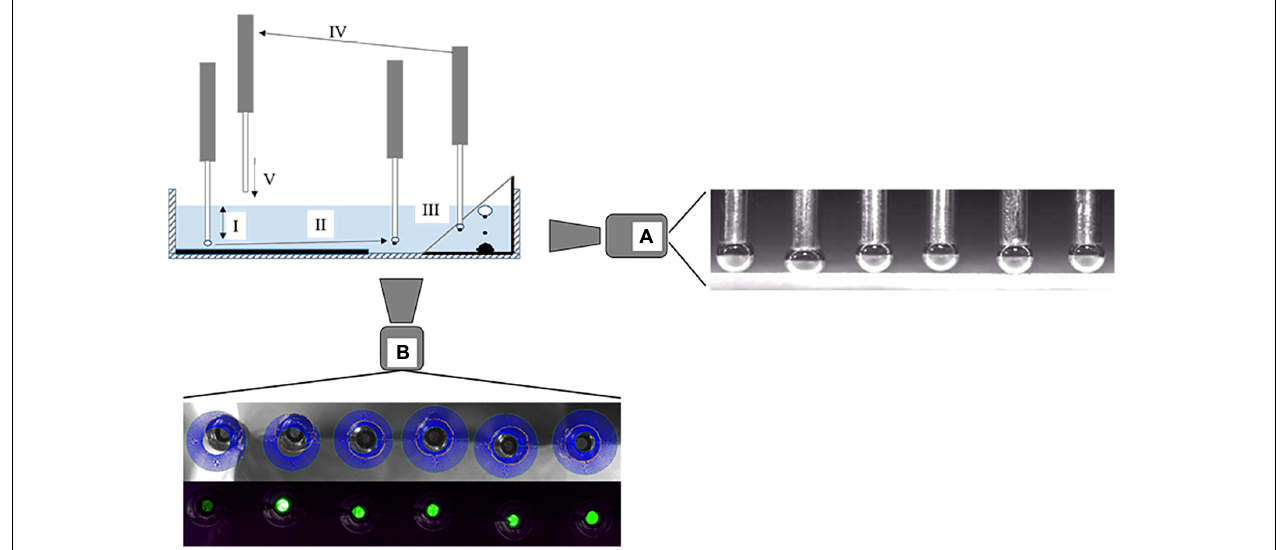
FIGURE 1 | Operating diagram of the ACTA with typical steps of a measurement cycle: (I) Bubbles are formed and approach the particle bed, rest for a set contact time and recede afterward again to the initial position. The initial distances of the needles varied to obtain different H between bubbles and the particle bed for a set contact time and the approach, rest and retraction of the bubbles are recorded with a high-speed camera (A). A representative image of the position of the bubbles relative to the particle bed at closest approach is given next to camera (A). (II) Bubbles are moved to the viewing window and images are taken by a digital microscope (B), representative images for the bubble size analysis and particle detection are shown below microscope (B). (III) Bubbles are moved to a collection bin and detached from the needles. (IV) The needles are lifted up until the needle tips are above the liquid, flushed with air for cleaning and simultaneously moved horizontally. (V) The needles are lowered slowly over an untouched spot of the particle bed into the liquid and the next cycle starts (as adapted from Hartmann and Serna-Guerrero, 2020).